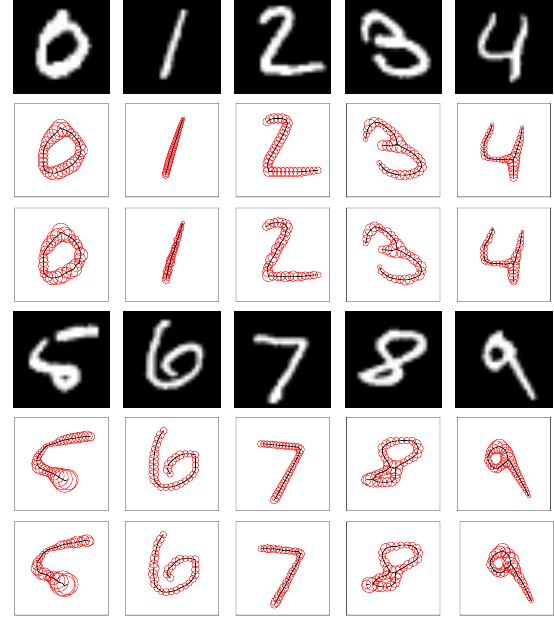
Figure 4. Autoencoder results. Source images (1st and 4th rows), their skeletons (2nd and 5th rows) and skeletons reconstructed with the autoencoder (3rd and 6th